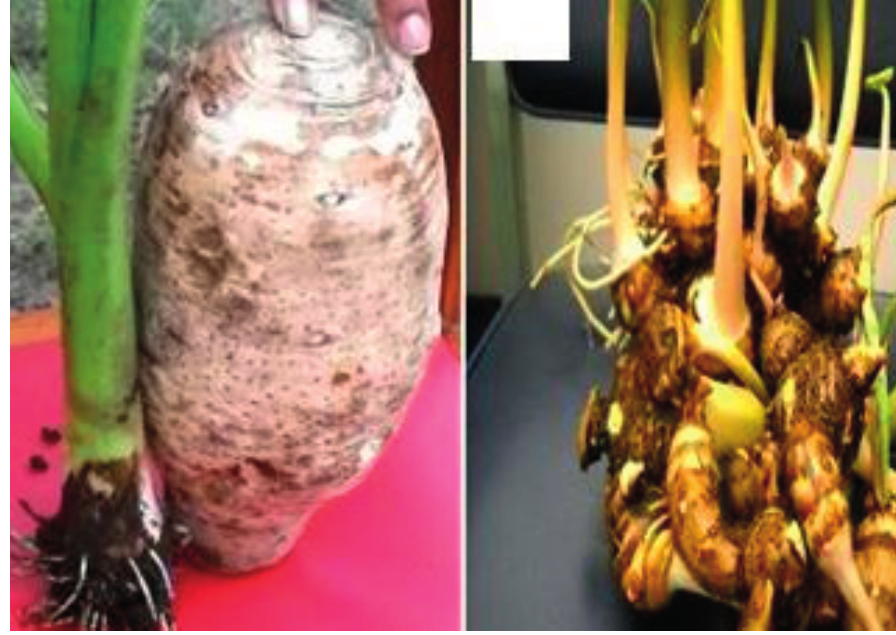
Figure 4. Taro landraces: ( Left ) Var. esculenta—dasheen with one main corm and a huli used as planting material and, ( Right ) Var. antiquorum—eddoe with numerous side cormels. Source